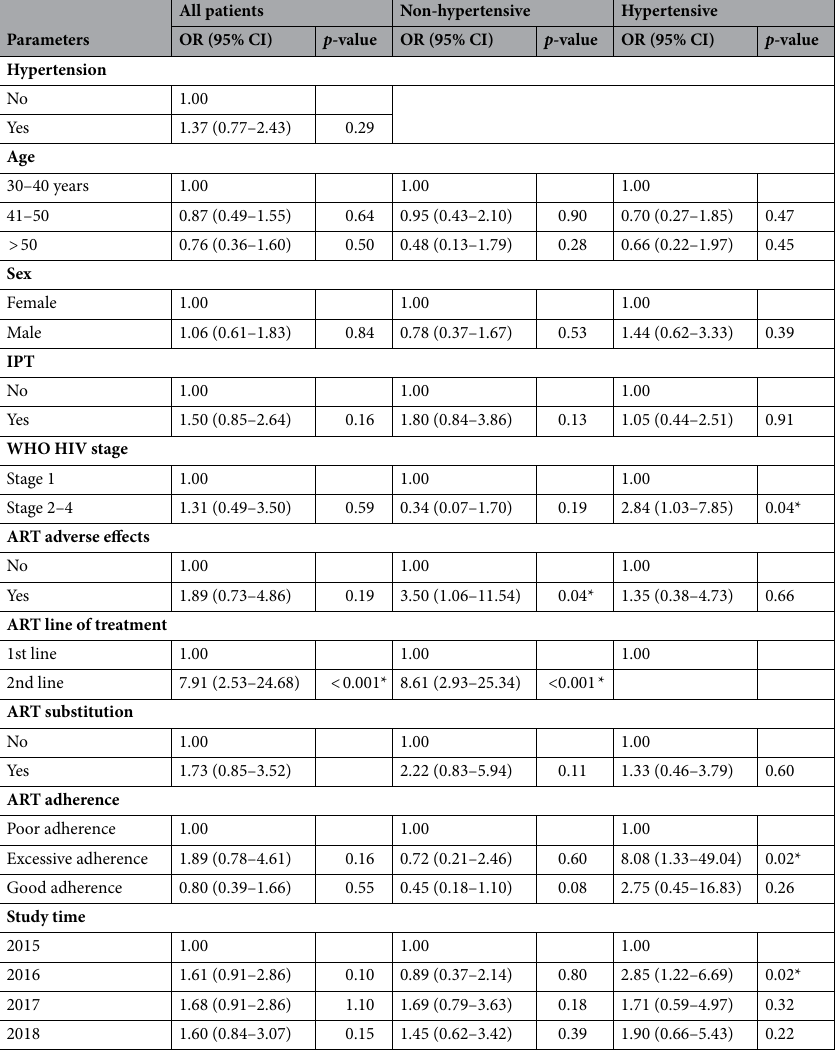
Table 4. Factors associated with viral load. IPT: isoniazid preventive therapy; HIV: human immunodeficiency virus; > : greater than; CI: confidence interval; < : less than; OR: odds ratio; –: independent variable has collinearity with independent variable; 1.00: reference. *Statistically significant